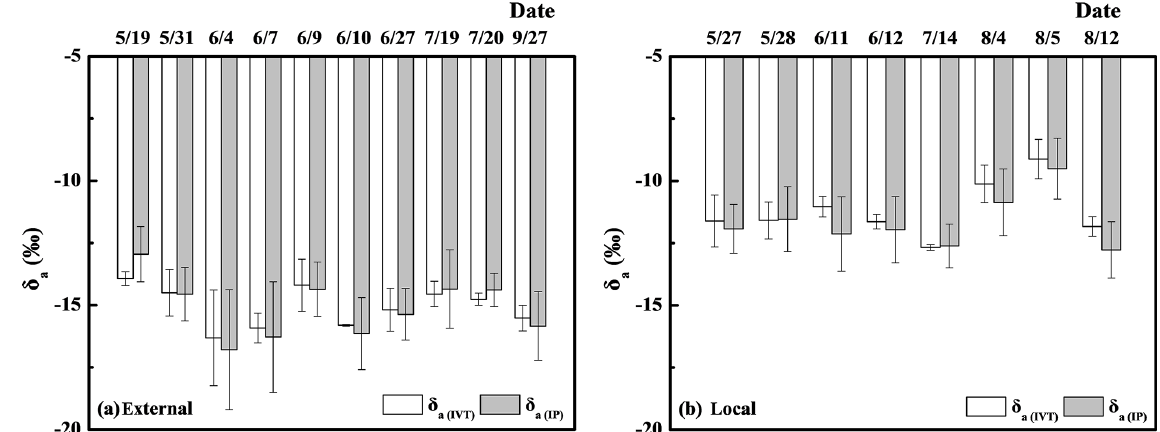
Figure 3. The daily average values of the estimated isotope composition of ambient vapor using the intersection point method ( δ a(IP) ) and the intermediate value theorem method ( δ a(IVT) ) after filtering. The Hybrid Single Particle Lagrangian Integrated Trajectory (HYSPLIT) backward trajectory showed both external (a) and local origins (b) , respectively. Please note that the date format in this figure is